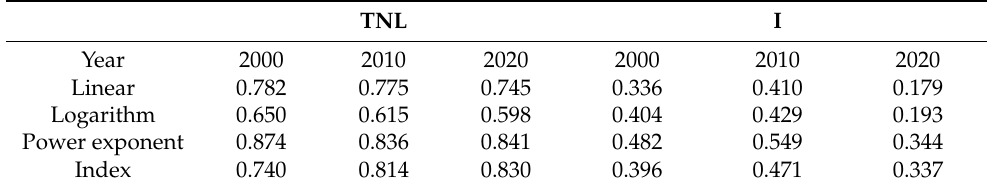
Table 1. Data statistics of R 2